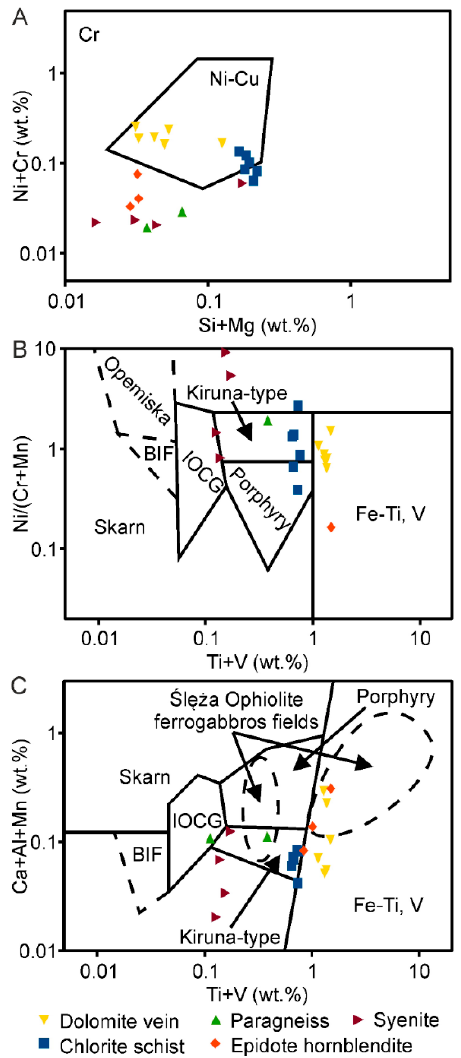
Figure 13. Discrimination diagrams of various types of deposits, based on the composition of magnetite from an ore body. Diagrams modified after Dupuis and Beaudoin [67]; magnetites from country rocks are shown for comparison. ( A ) Si + Mg vs. Ni + Cr diagram for discrimination of the Ni-Cu-PGE magmatic massive sulfides and Cr deposits of podiform chromite-type; ( B ) Ti + V vs. Ni / (Cr + Mn) diagram for discrimination of the Fe-Cu skarns, Archean Opemiska-type Cu veins, banded iron formation (BIF), iron oxide-copper-gold (IOCG), Kiruna-type apatite-magnetite, Archean Au-Cu porphyry, and magmatic Fe-Ti and V deposits (ferrogabbros); ( C ) Ti + V vs. Ca + Al + Mn diagram for discrimination of the Fe-Cu skarns, banded iron formation (BIF), iron oxide-copper-gold (IOCG), Kiruna-type apatite-magnetite, Archean Au-Cu porphyry, and magmatic Fe-Ti and V deposits (ferrogabbros). For comparison, fields of the magmatic Fe-Ti (and V) deposits, hosted in metabasites (ferrogabbro-ferrobasalt) of the ´Sl˛e˙za Ophiolite (the Central-Sudetic Ophiolite) are presented after Wojtulek et al.